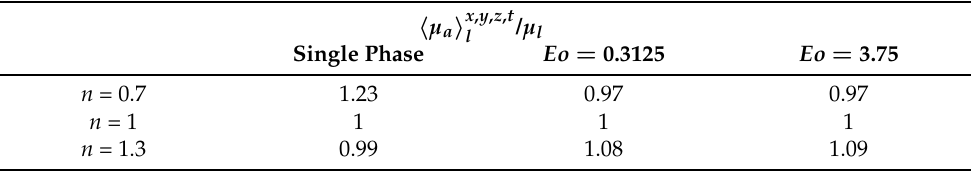
Table 2. Average normalized liquid dynamic viscosities for all nine setups. The viscosity fields have been averaged over all spatial directions and over time, which is indicated by (cid:104)·(cid:105) x , y , z , t